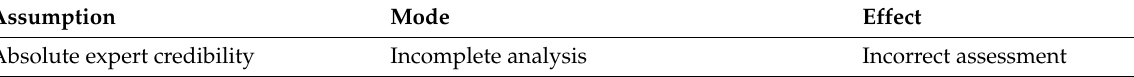
Table 5. Assumption modes and effect